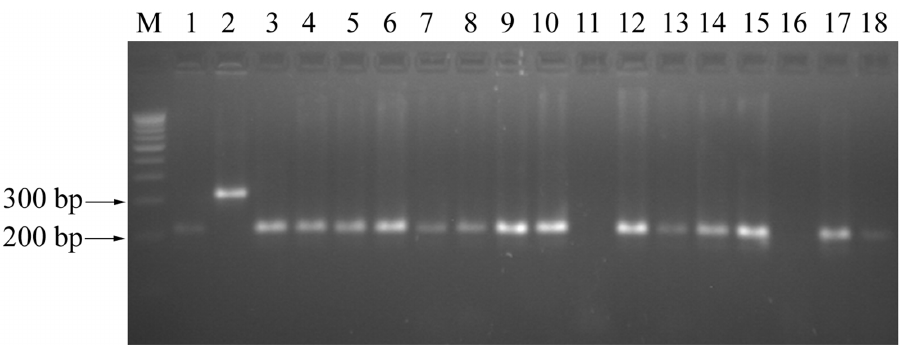
Fig 6. PCR amplification using genic-SSR marker VMgSSR-30 in 18 black gram genotypes.